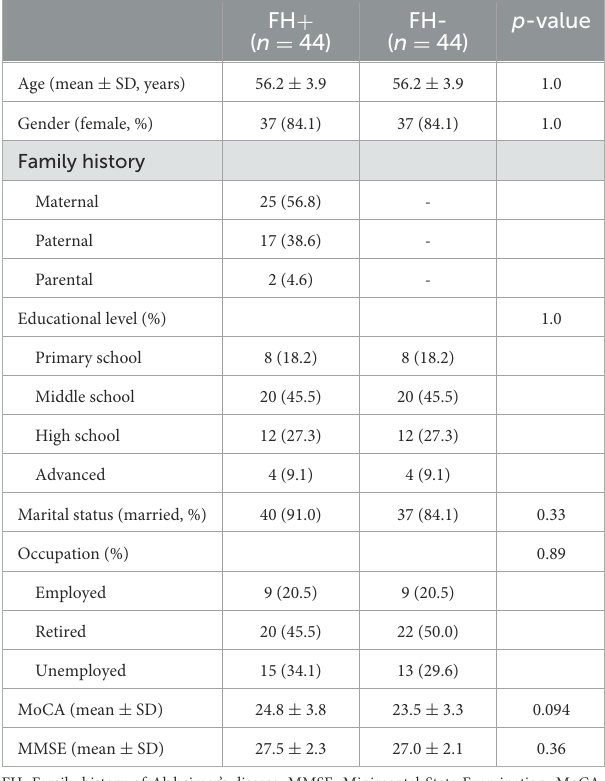
TABLE 1 Demographic features for participants with or without family history of Alzheimer’s